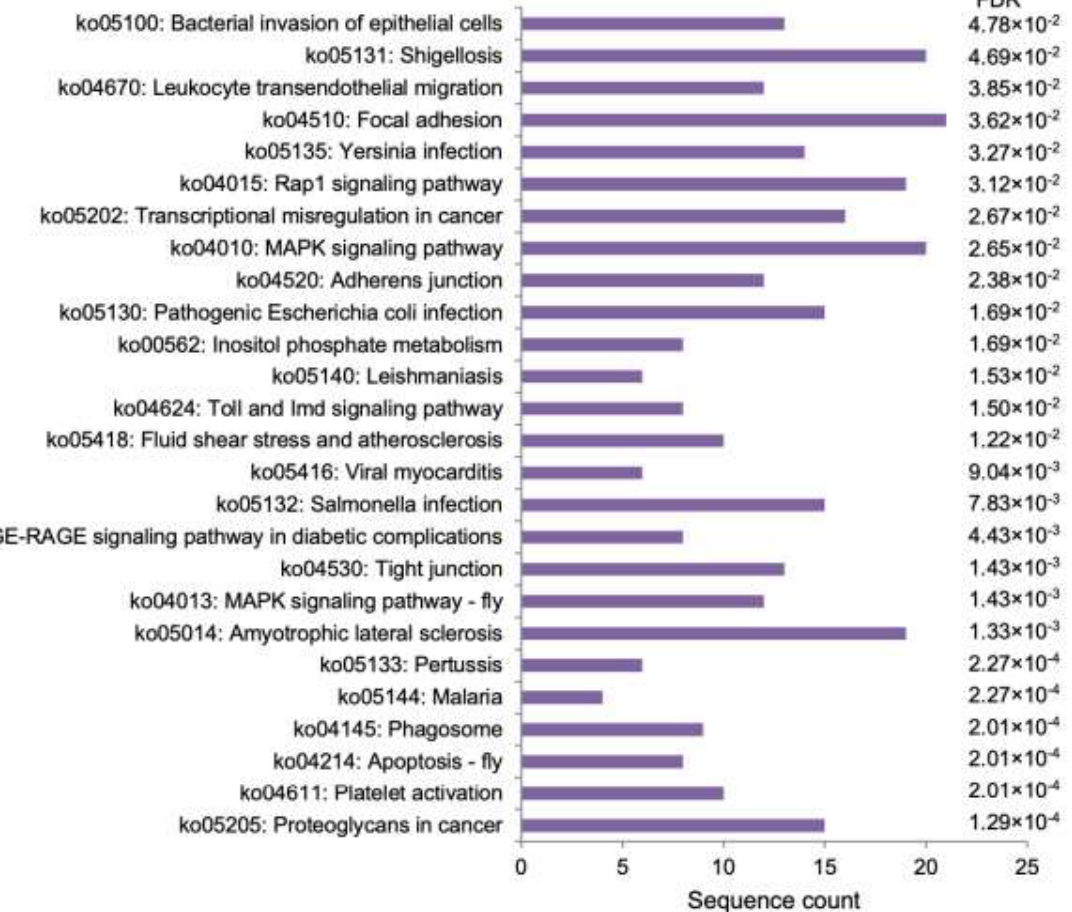
Figure 3. Enriched KEGG pathways of C. rotundicauda differentially expressed genes (DEGs). Se- quence count and false discovery rate (FDR) are shown.